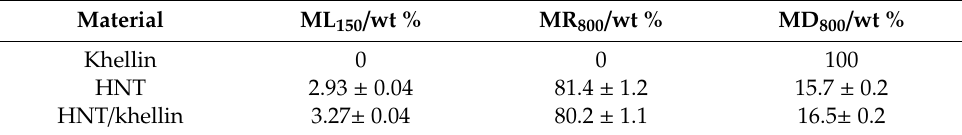
Table 2. Thermogravimetric parameters of Khellin, HNT and HNT/Khellin composite.